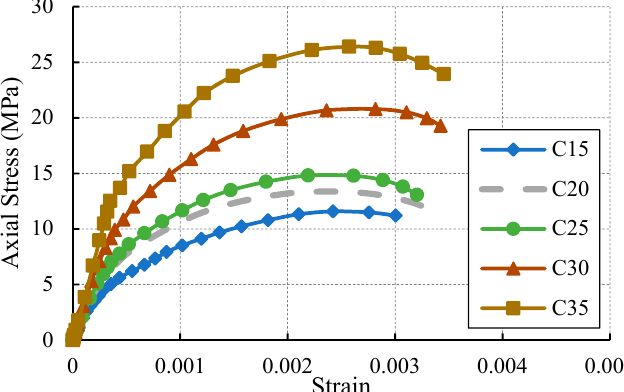
Figure 14. Stress-Strain curve of the unconfined concrete cylinder of C15 to C35.